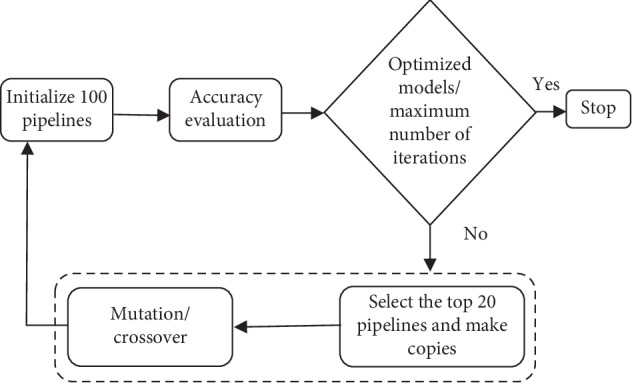
Flowchart of GP.